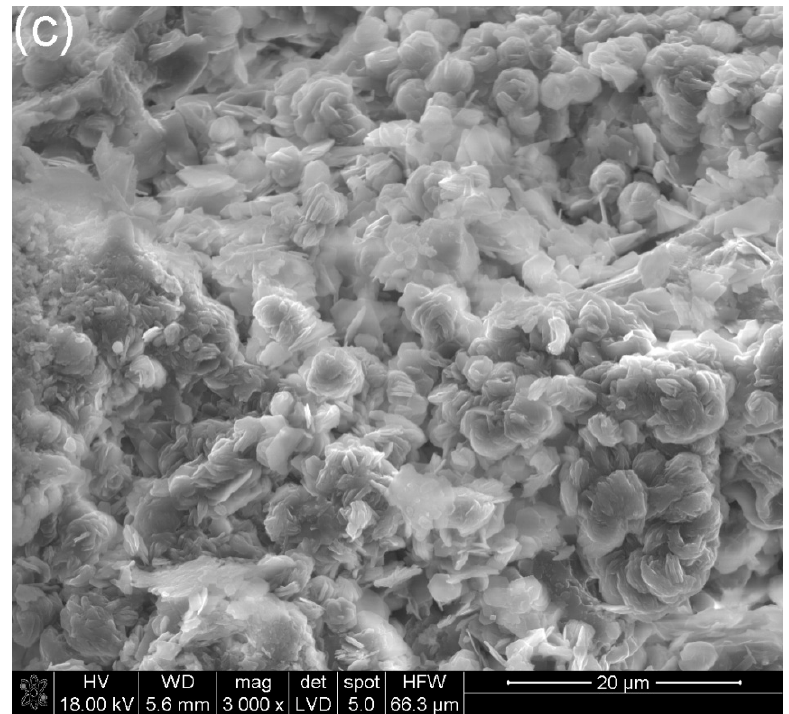
Figure 6. SEM image of the hydrated Sr 1.25 Ca 5.75 ZrAl 6 O 18 cement (Sample A) at the age of 7 d ( a ). Spot 1 EDS analysis; ( b ) EDS spectrum of the sample in the microarea 1—Ca-rich (Sr,C) 3 AH 6 ; ( c ) overview of microstructure.